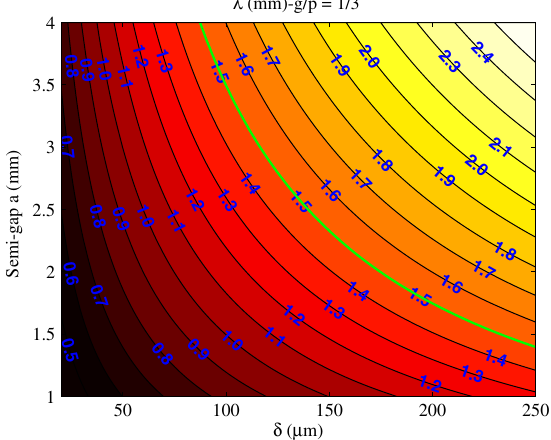
FIG. 5. Wavelength of the wakefield generated by a corrugated plate as a function of δ and a assuming a ratio g over p equal to 1 = 3 . The level corresponding to the case λ total bunch length is also highlighted.